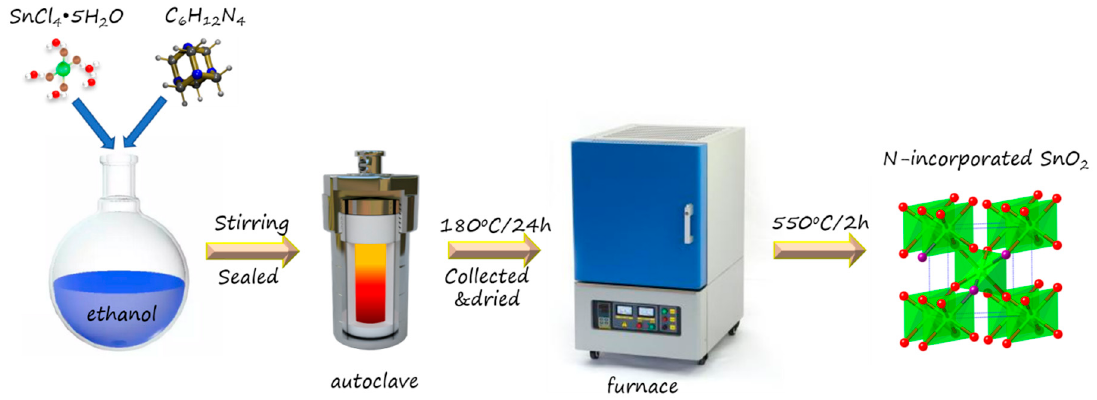
Figure 1. Scheme of the synthesis process of N-incorporated SnO 2 nanostructure.